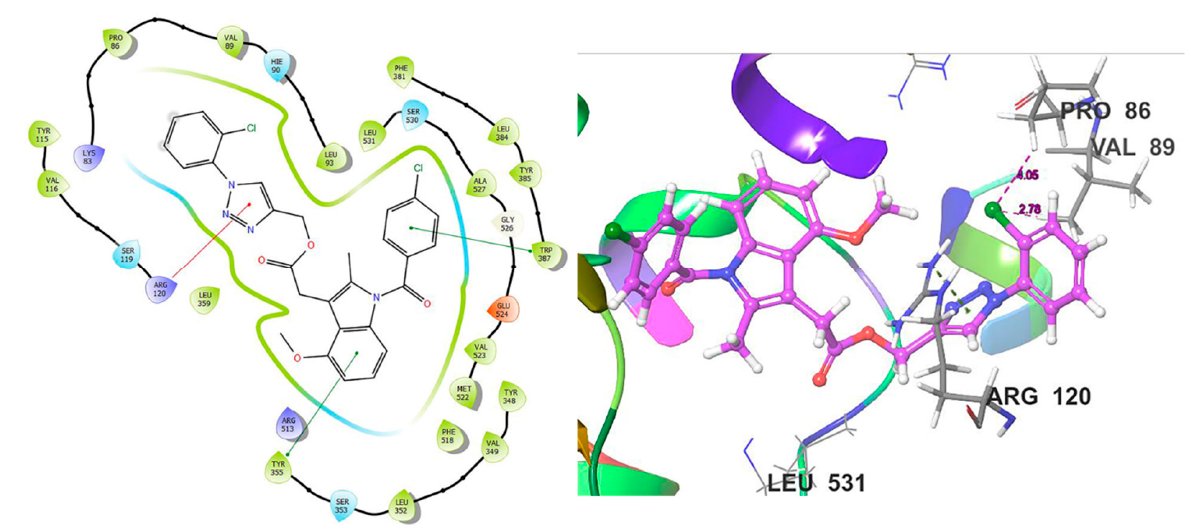
Figure 8. Binding interactions and docked pose of compound 5a in the COX-2 crystal structure, PDB: 6COX. The choro group interacts with Pro86 and Val89, conferring 5a COX-2 selectivity. Compared to Indomethacin and Ibuprofen, our compound 5e is more potent and selective for COX-2. Figure 9 shows an overlay of the docked poses of Indomethacin and Ibuprofen in the COX2 crystal structure, 6COX. The carboxylic acid group interacted with Arg120, but no contacts with Pro 86 and Val89 were observed. The binding mode indicates that the selectivity and potency for COX-2 could be achieved by appending groups that can target the loop residues, including Pro86, Asn87, Thr88, and Val89. We used the carboxylic acid of indomethacin as the seed group to which a phenyl-substituted triazole ring was conjugated. The position of the substituent on the phenyl ring proved critical to achieving selectivity and potency for COX-2, as demonstrated by the 2-chloro substituent in 5a .